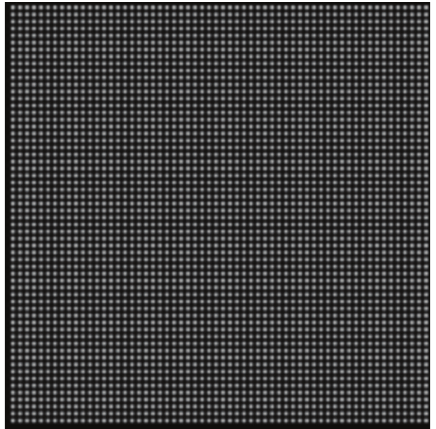
Figure 10: The observation point distribution of the scanning